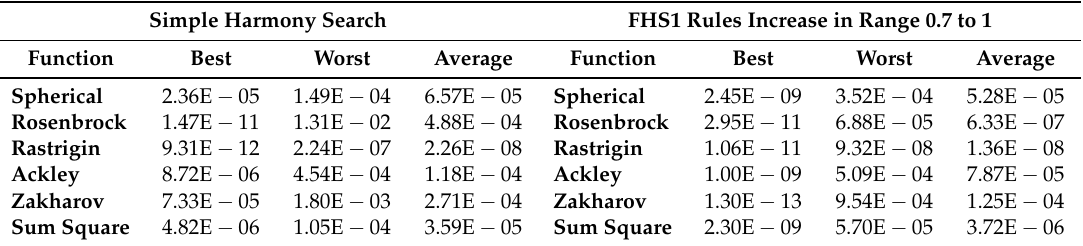
Table 5. Comparison of results obtained with FHS1 and the harmony search